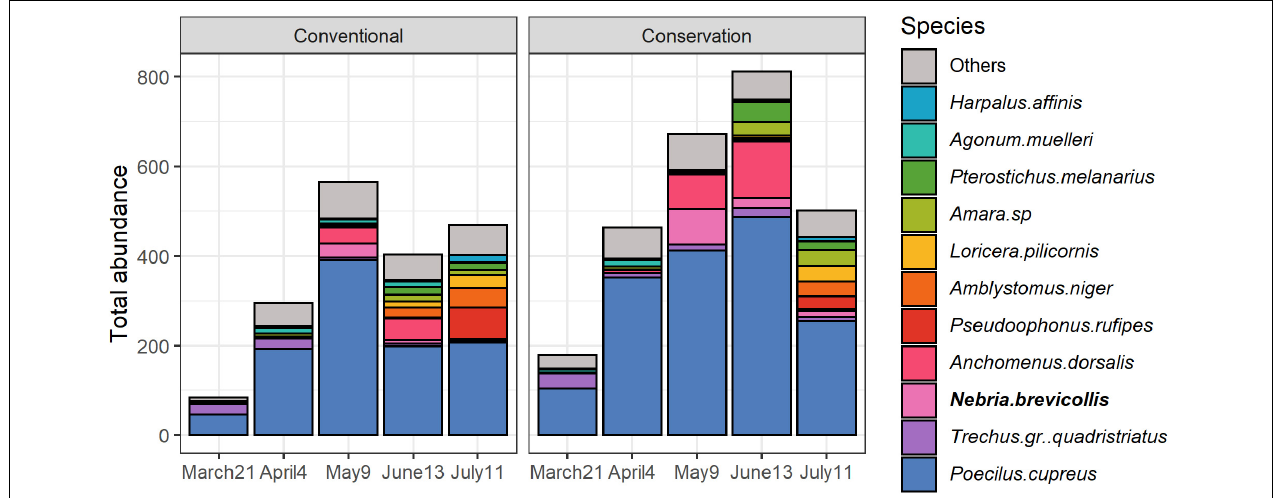
FIGURE 4 | Variations over time and soil management of cumulative abundance of carabid species in the circulating community representing at least 80% of the total abundance. Indicator species are bolded.